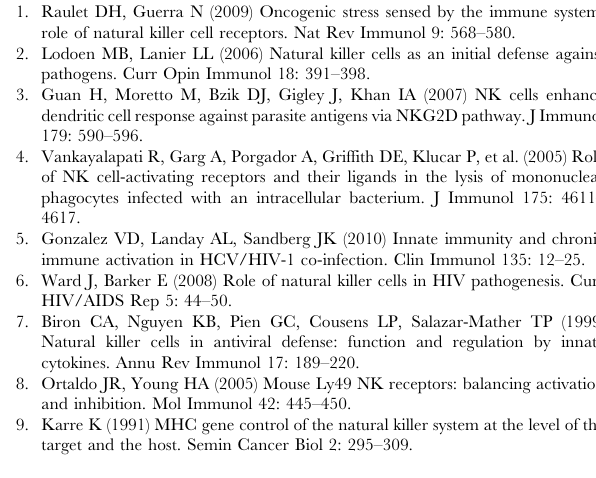
NK cells from the indicated mice strains was analyzed by RT- Figure S4 Ly49P + 2B4 reporter cell stimulation by MCMV- infected MEF cells produced from FVB-Tg(D k ) + mice. (A) Stimulation of Ly49P reporter cells by co-culture with MEF cells from the indicated backgrounds that were uninfected (black histograms) or MCMV infected at an MOI of 1 for 24 h (grey histograms). Ly49P-specific activation was detected by NFAT- GFP expression using flow cytometry. (B) Stimulation of Ly49P or Ly49H reporter cells by co-culture with FVB-Tg(D k ) + MEF cells that were uninfected (left) or infected with D m157 (middle) or D m04 (right) MCMV deletion mutants. Reporter cell stimulation was detected by monitoring expression of GFP by flow cytometry. The percentage of positive cells in each gated population is indicated. Figure S5 Co-expression of H2-D q and H2-D k in FVB-Tg(D k ) + mice. Endogenous H2 -D q (bottom) and transgenic H2 -D k (top) expression in splenic T and B cells from FVB-Tg(D k ) + transgenic (black peak) or nontransgenic (black peak) littermates was determined by flow cytometry. Figure S6 Ly49 receptor expression on NK cells from FVB H2- D k transgenic and nontransgenic mice. (A) The indicated Ly49 specific monoclonal antibodies (black peak) or isotype controls (red peak) were gated on NKp46 + splenic NK cells from FVB-Tg(D k ) 2 and FVB-Tg(D k ) + mice and analyzed by FACS. The proportion of Ly49 receptor expression is indicated in each histogram. (B) Quantification of expression frequency of the indicated NK receptors in FVB-Tg(D k ) 2 and FVB-Tg(D k ) + mice. Found at: doi:10.1371/journal.pgen.1001368.s006 (1.81 MB EPS) Figure S7 Ly49 receptor and MHC class I expression on NK cells from F3 mice. The indicated Ly49-specific monoclonal antibodies were gated on NKp46 + splenic NK cells from F3 mice and the proportion of expression is indicated in each histogram. Right panels: expression of MHC-I H2 -D q and H2 -D k molecules on total splenocytes was determined. 2–3 mice per genotype were analyzed. We found that the expression of the activating and the inhibitory receptors were almost comparable between strains for the exception of Ly49G which was barely detectable in the Cmv3 FVB /H2 0 /Tg(D k ) 2 mice using both anti- Ly49G antibodies